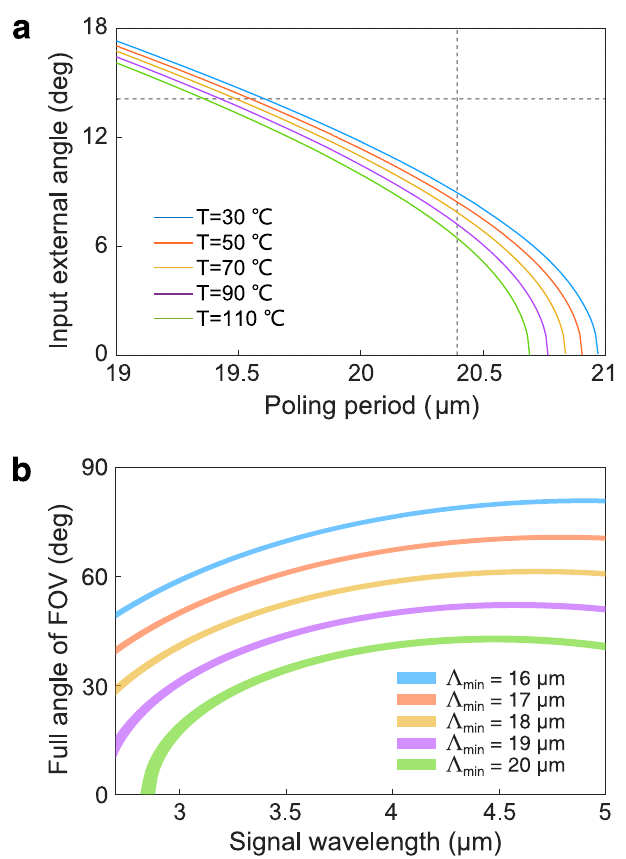
Fig. 2 Dependence of the accepted angle on various phase-matching conditions. a Input external angle as a function of the optimized poling period at different operation temperatures. The horizontal dashed line denotes the radius of the entrance pupil of the imaging system, while the vertical dashed line represents the condition for the upconversion imaging based on a PPLN crystal. b Full fi eld-of-view angle versus the signal wavelength in the proposed wide- fi eld scenario at the presence of various lower-bound poling periods. The vertical width for each plot band indicates the variation due to the temperature change from 30 to 110 °C.